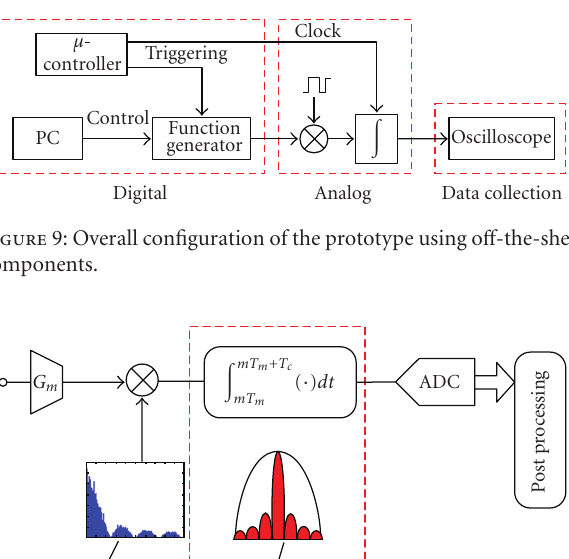
Figure 8: MSE of the reconstructed signal with di ff erent overlap- ping ratio when there is clock leakage, where the input signal is an 18-sparse multi-carrier signal with 128 possible subcarriers and sampled by the 2-path PSCS working at 56.25% of the Nyquist rate. relative location of the leakage frequency to the filter nulls, as illustrated in Figure 7.